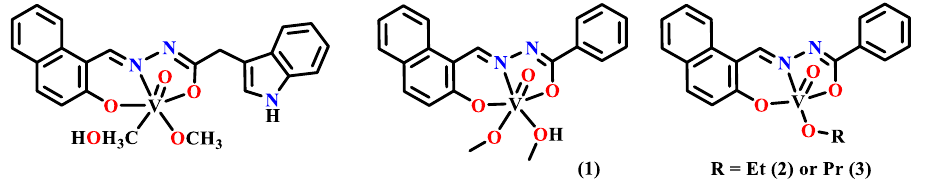
Figure 7. Several vanadium (V) complexes of naphthylhydrazone with indole-3-acetamide group or benzamide as a side chain.